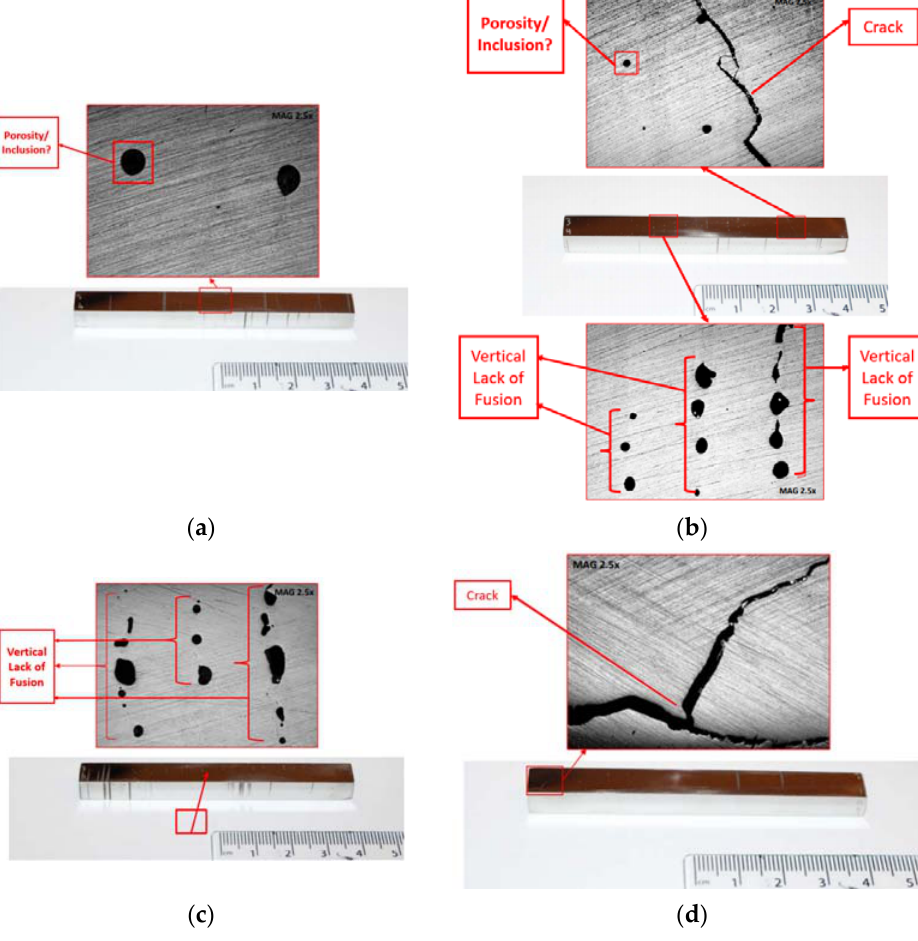
Figure 8. Primary microscopic observations with details of various defects such as vertical lack of fusion, porosity, inclusions, and cracks in different specimens: ( a ) specimen No. 4, ( b ) specimen No. 5, ( c ) specimen No. 6, and ( d ) specimen No. 7.